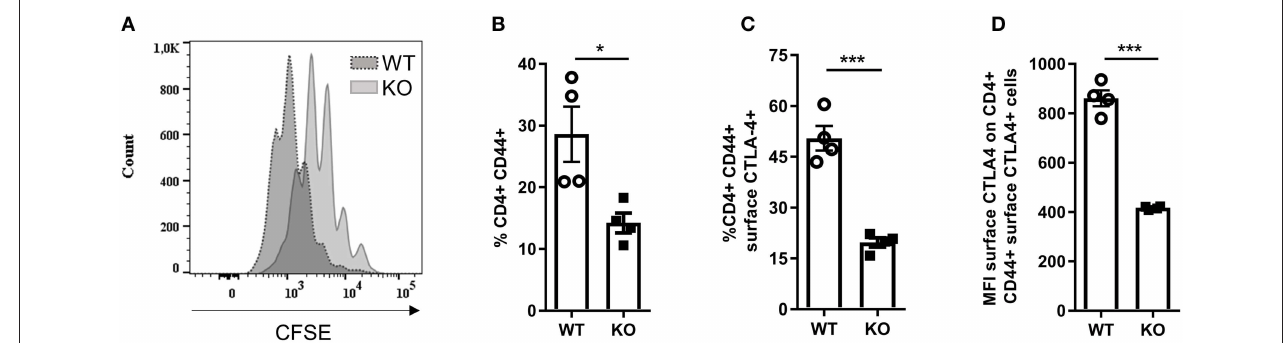
FIGURE 4 | Activation of Malt1 -KO CD4 + T is altered. (A) CFSE labeled CD4 + T cells stimulated for 72h with plate bound α -CD3 and soluble α -CD28. The CFSE overlaid histograms displaying the proliferation of WT or Malt1- KO CD4 + T cells (age mice: 10 weeks lesion-free). (B) Splenocytes were stimulated for 4h with PMA and IO (same for C and D) in order to determine the percentage of CD44 + CD4 + T cells. (C) Percentage of CD44 + CD4 + T cells that express CTLA-4 on their surface. (D) Mean fluorescence intensity (MFI) of CTLA-4 on CD44 + CD4 + T cells that express CTLA-4 on their surface. For (B–D) open circles (WT: n = 4) and black squares (KO: n = 4) represent individual mice. The mean ± SEM is indicated on the graphs. The statistical significance between groups was calculated with an unpaired 2-tailed Student’s t -test: * P < 0.05 and *** P < 0.001.